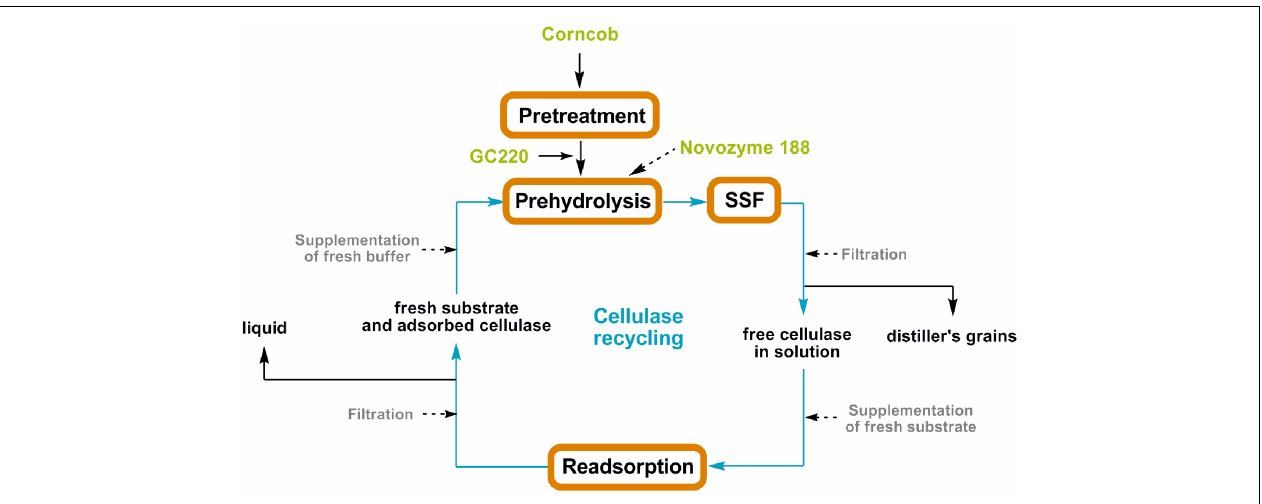
FIGURE 1 | Enzyme recycling strategy integrating cellulase re-adsorption with the SSF process .